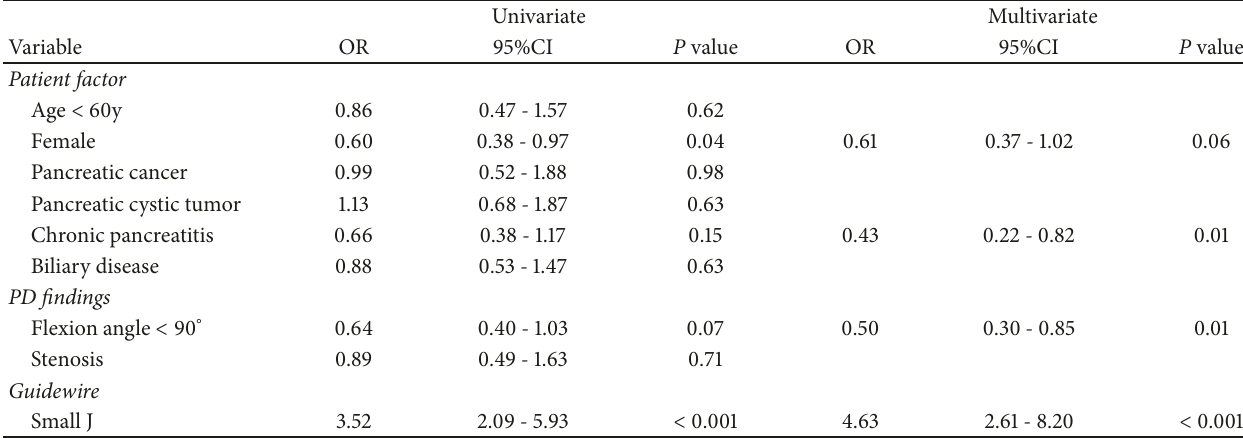
Table 3: Univariate and multivariate analysis of factors for procedure completion.